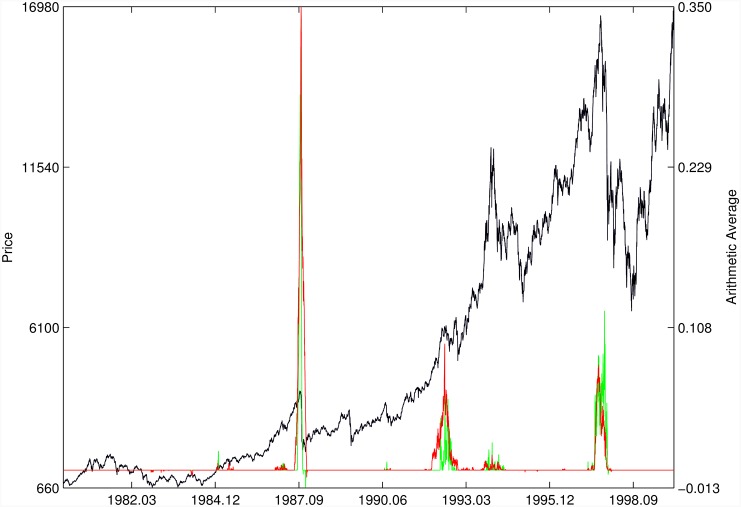
Hong Kong 1987/1994/1997.Same as Fig 10.